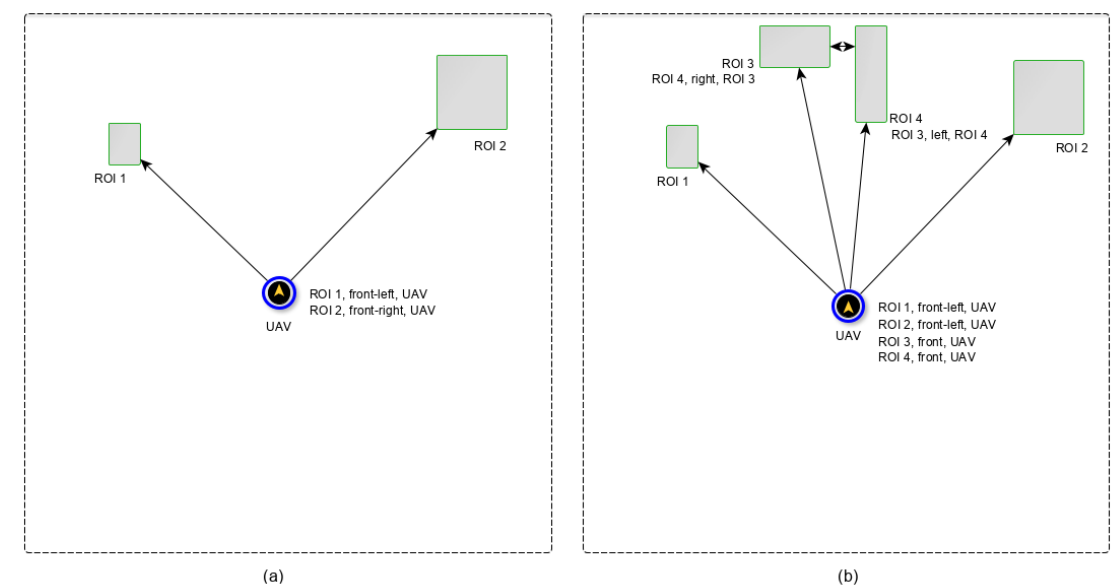
Figure 4. ( a ) A coordinate map that represents the spatial relationship between the UAV and ROIs identified in the environment. ( b ) A second coordinate map with additional spatial information between ROIs that are close to each other. In order to establish the positions of the identified ROIs relative to the UAV, Equations (5) and (6) are defined for segmenting the UAV’s field of view into five regions as shown in Figure 5. These trivial equations allow the UAV to situate ROIs in the environment.